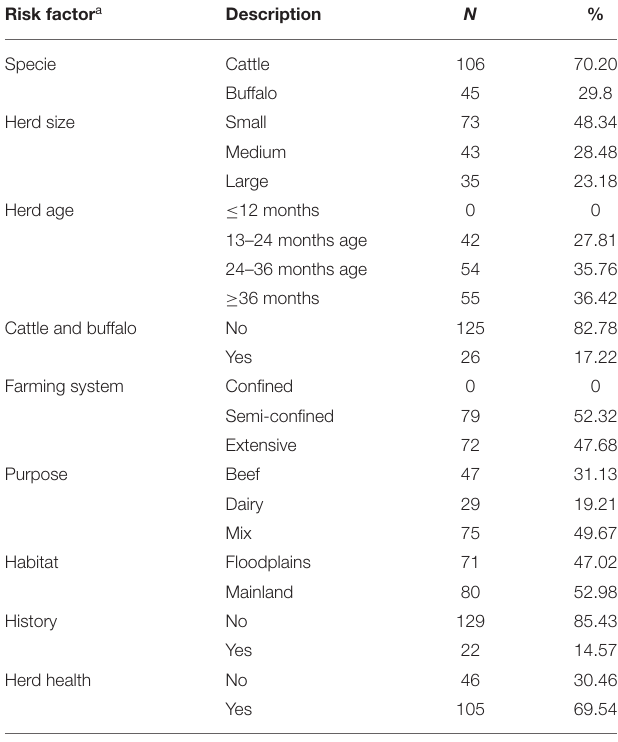
TABLE 1 | Distribution of the sampling by origin, number of animals inspected, sample by species, and percent of the sampling, Amazonas State, Brazil. Region Municipality Animals inspected Buffalo Cattle